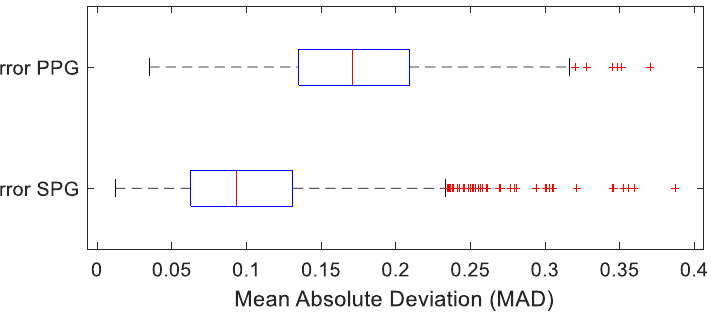
Figure 5. Beat-averaged MAD of fiAP vs. PPG (top, average MAD 0.17) and fiAP vs. SPG (bottom, average MAD 0.09).